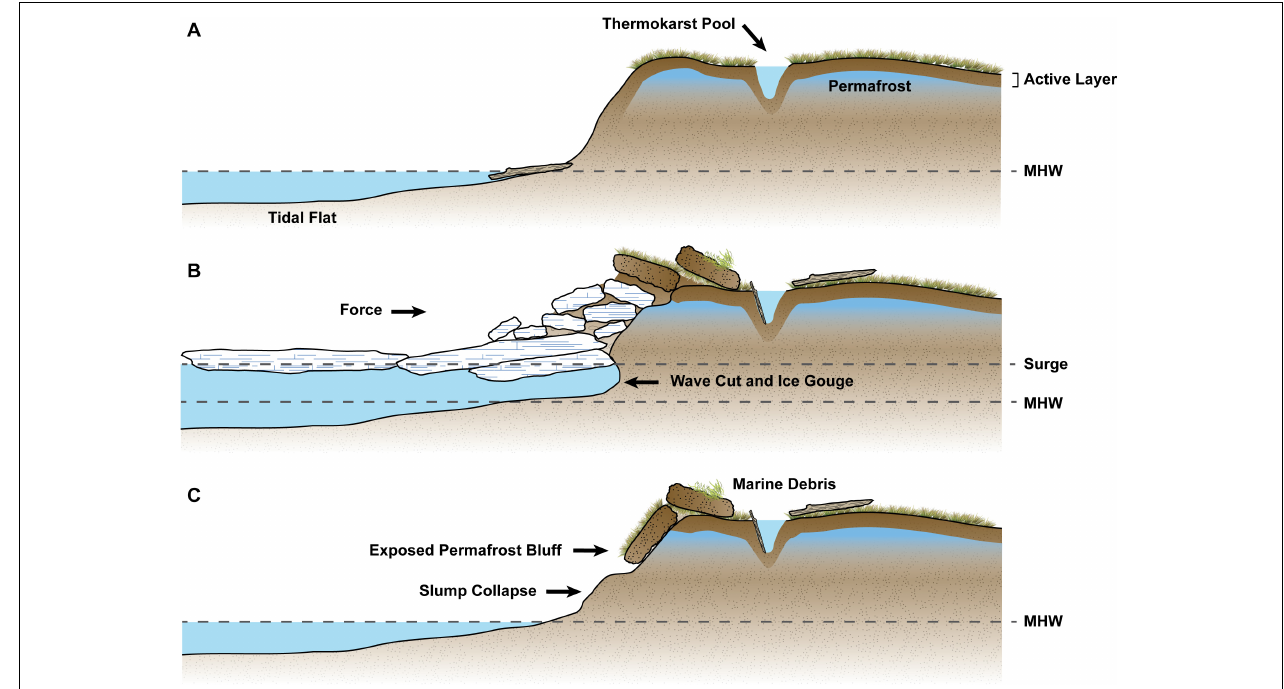
FIGURE 10 | Conceptual diagram showing the before (A) , during (B) , and after (C) cross-sections of the Western portion of coastline ( Figure 3 ). Key features are annotated with arrows. (A) Prior to the event, there were shore parallel thermokarst cracks approximately 10 m inland from the bluff edge. Note the steeper bluff face and deeper offshore water when compared to the Eastern section ( Figure 8 ). (B) During the event, ice was shoved into the steep bluff face gouging the bluff toe and sheering off large blocks of sediment along the bottom of the active layer. Notice how the lateral abrasion from the ice push leads to the exposure of permafrost at the bluff, compounding further erosion. (C) After the ice push, it was evident that the bluff face had slumped onto the beach with the large sediment blocks and thermokarst features remaining along the top of the bluff ( Figures 11E,F ). MHW, mean high